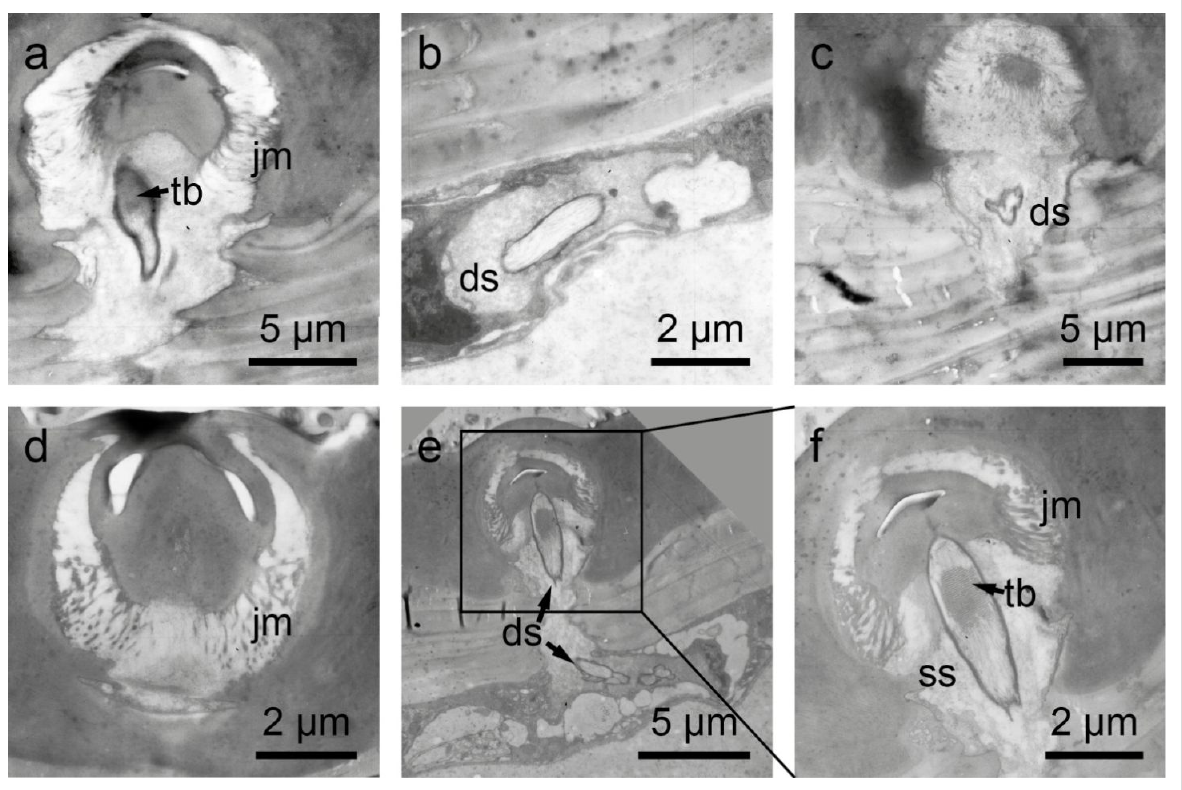
Figure 3: Transmission electron microscopy images of setae on the hemelytra of N. glauca . a–d) Clavus. a) Tubular body (tb) at the base of the seta. Note the joint membrane (jm). b) Outer dendritic segment with the dendritic sheath (ds) sectioned below the cuticle. c) Part of the dendrite in the outer receptor lymph cavity of the sensillum. The base of the seta is visible above the dendrite. d) Base of the seta with the joint membrane (jm). e,f) Mem- branous part of the hemelytra. e) Dendrite with an apical tubular body attached to the base of the seta. Below more proximal parts of the dendrite are shown. f) Detail of e. The tubular body (tb) is visible. The socket septum (ss) is attached to the tip of the dendrite where the tubular body is located.